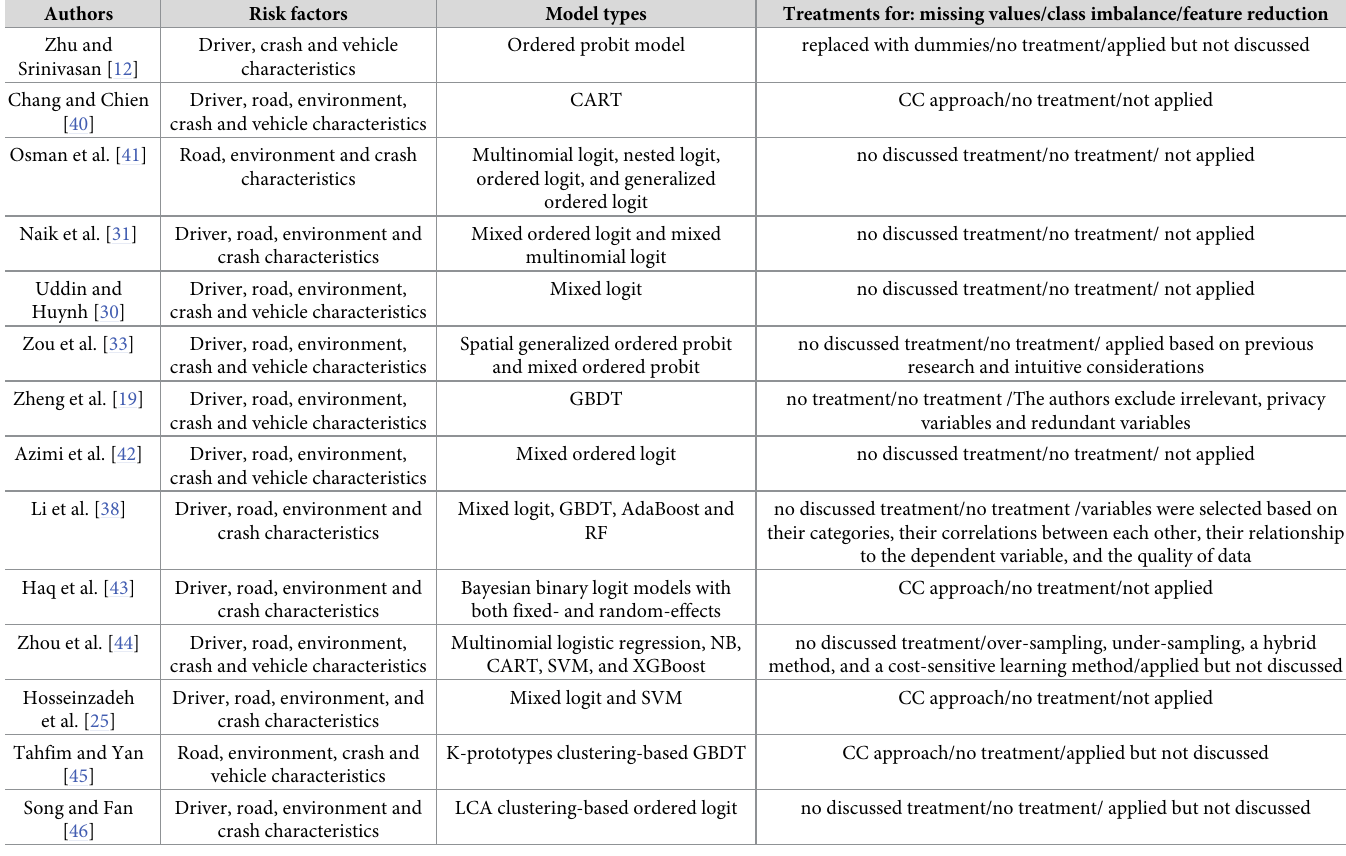
Table 1. Studies of the risk factors of truck-involved crash